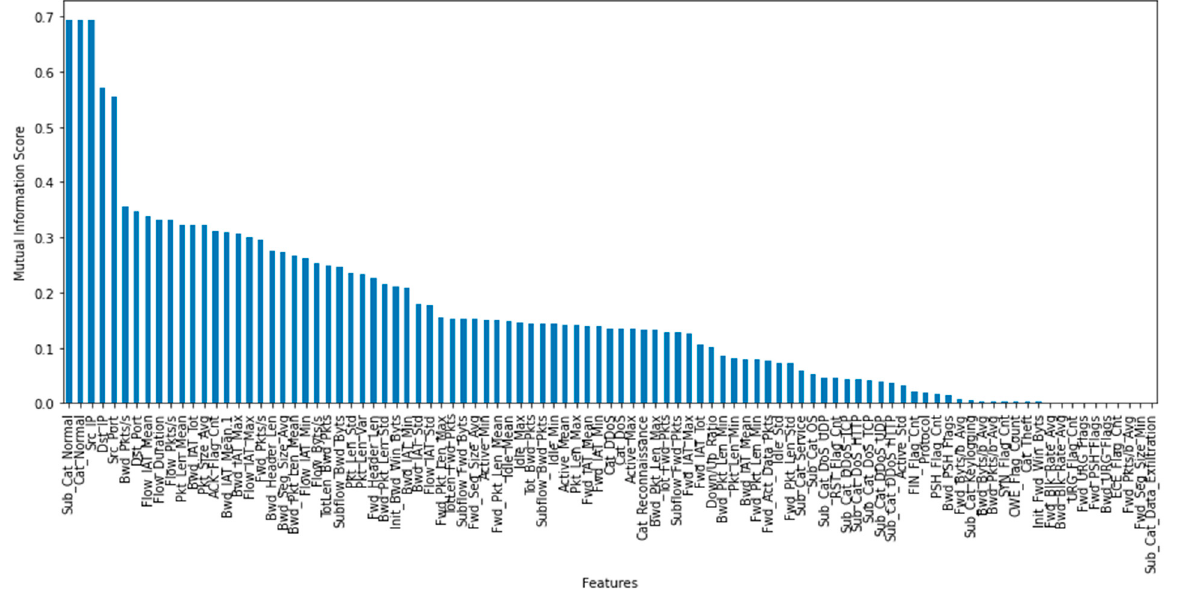
Figure 10. All types of features of the Bot-IoT dataset arranged in descending order based on MI score.